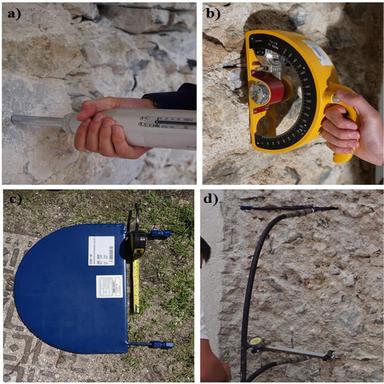
Photos of the experimental campaign: rebound hammer tests on stone and mortars (a and b, respectively); flat-jack and ongoing flat-jack tests (c and d, respectively).